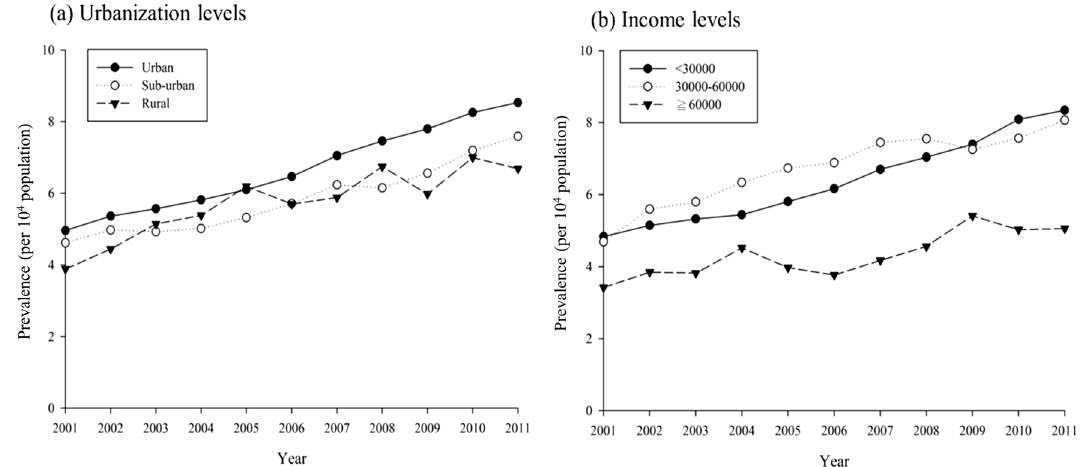
Figure 2. Prevalence of SLE from 2001 to 2011 by (a) urbanization levels and (b) income levels.